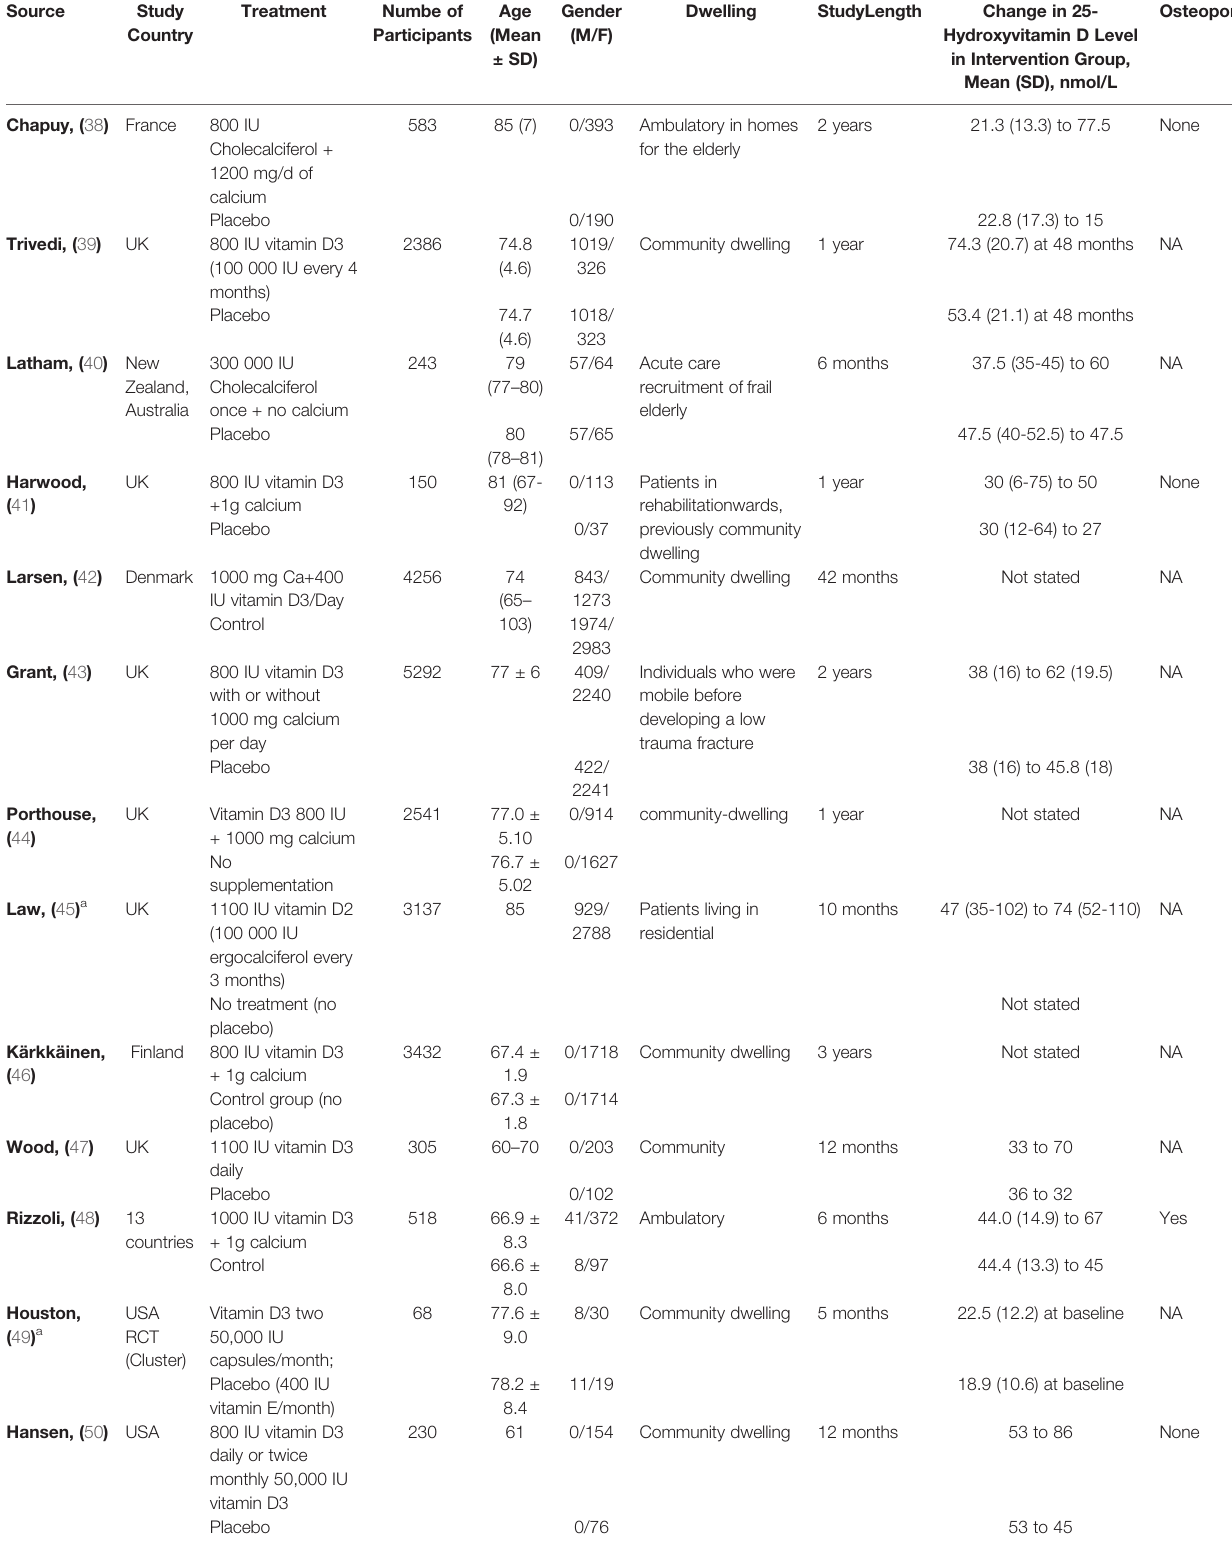
TABLE 2 | Trials of supplemental vitamin D excluded from the primary analyses but included in sensitivity